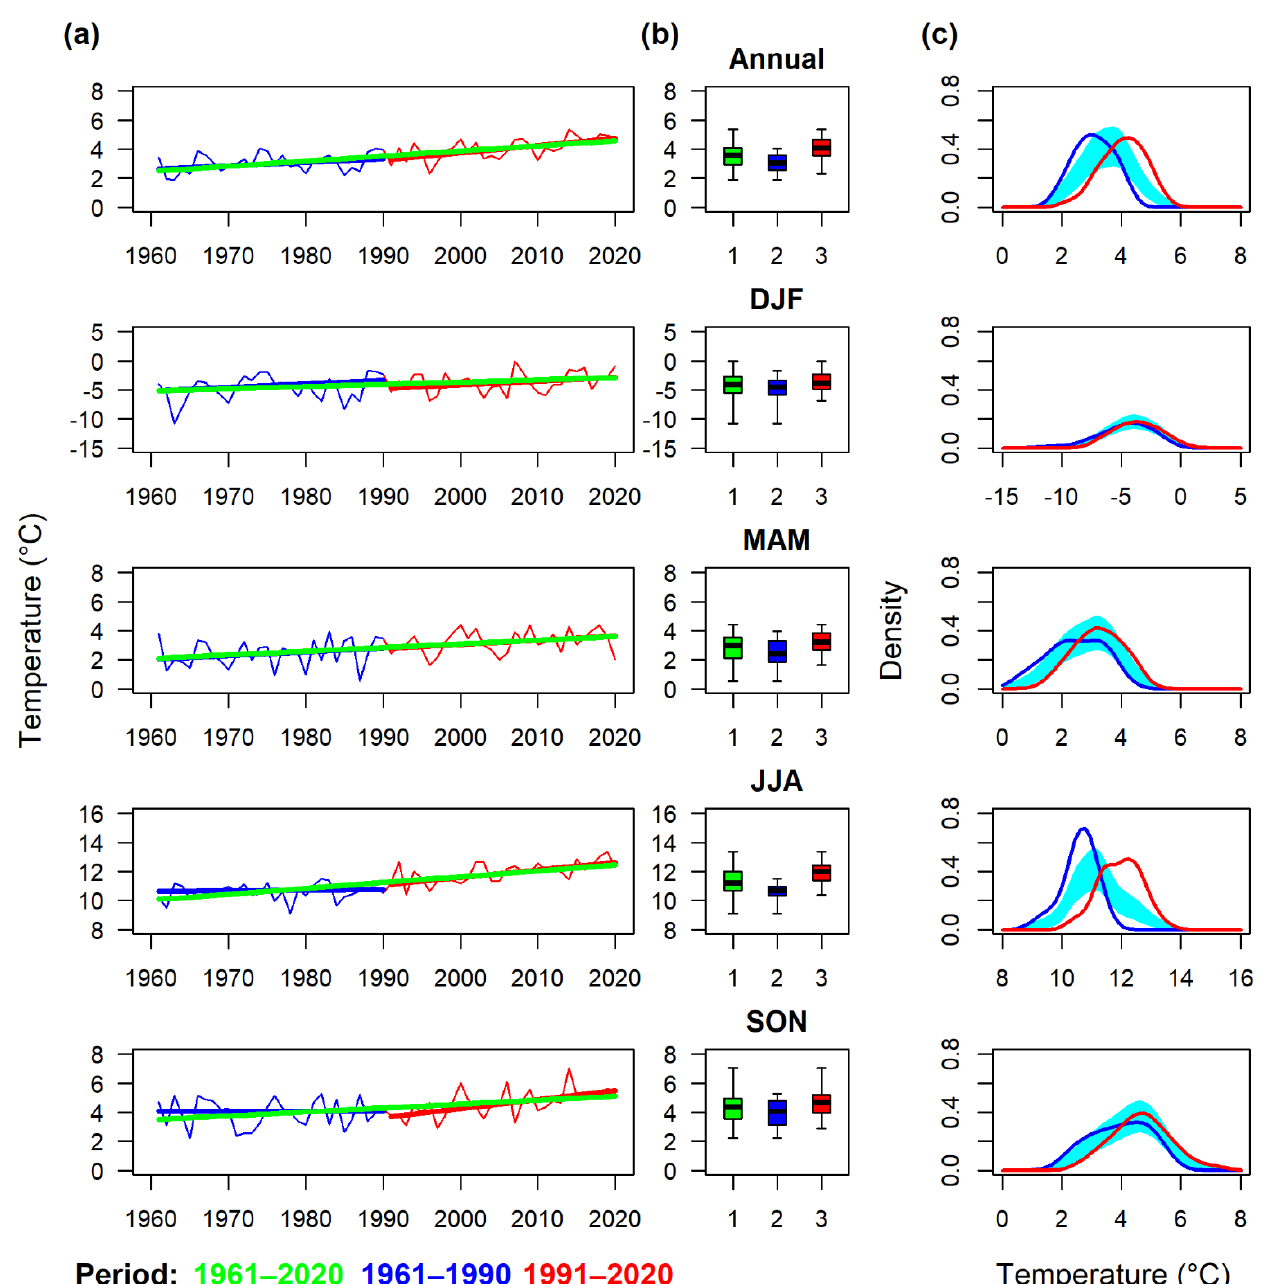
Figure 8. Annual and seasonal mean minimum temperature series for the territory of the Czech Republic in the 1961 – 2020 period: ( a ) fluctuations with linear trends in the entire period, 1961 – 1990 and 1991 – 2020; ( b ) box plots (median, lower and upper quartile, minimum, and maximum) for 1961 – 2020 (1), 1961 – 1990 (2), and 1991 – 2020 (3); ( c ) the density distribution of the series in 1961 – 1990 and 1991 – 2020. The density curves outside the reference band (green – blue) indicate a significant difference in the two distributions (and vice versa).